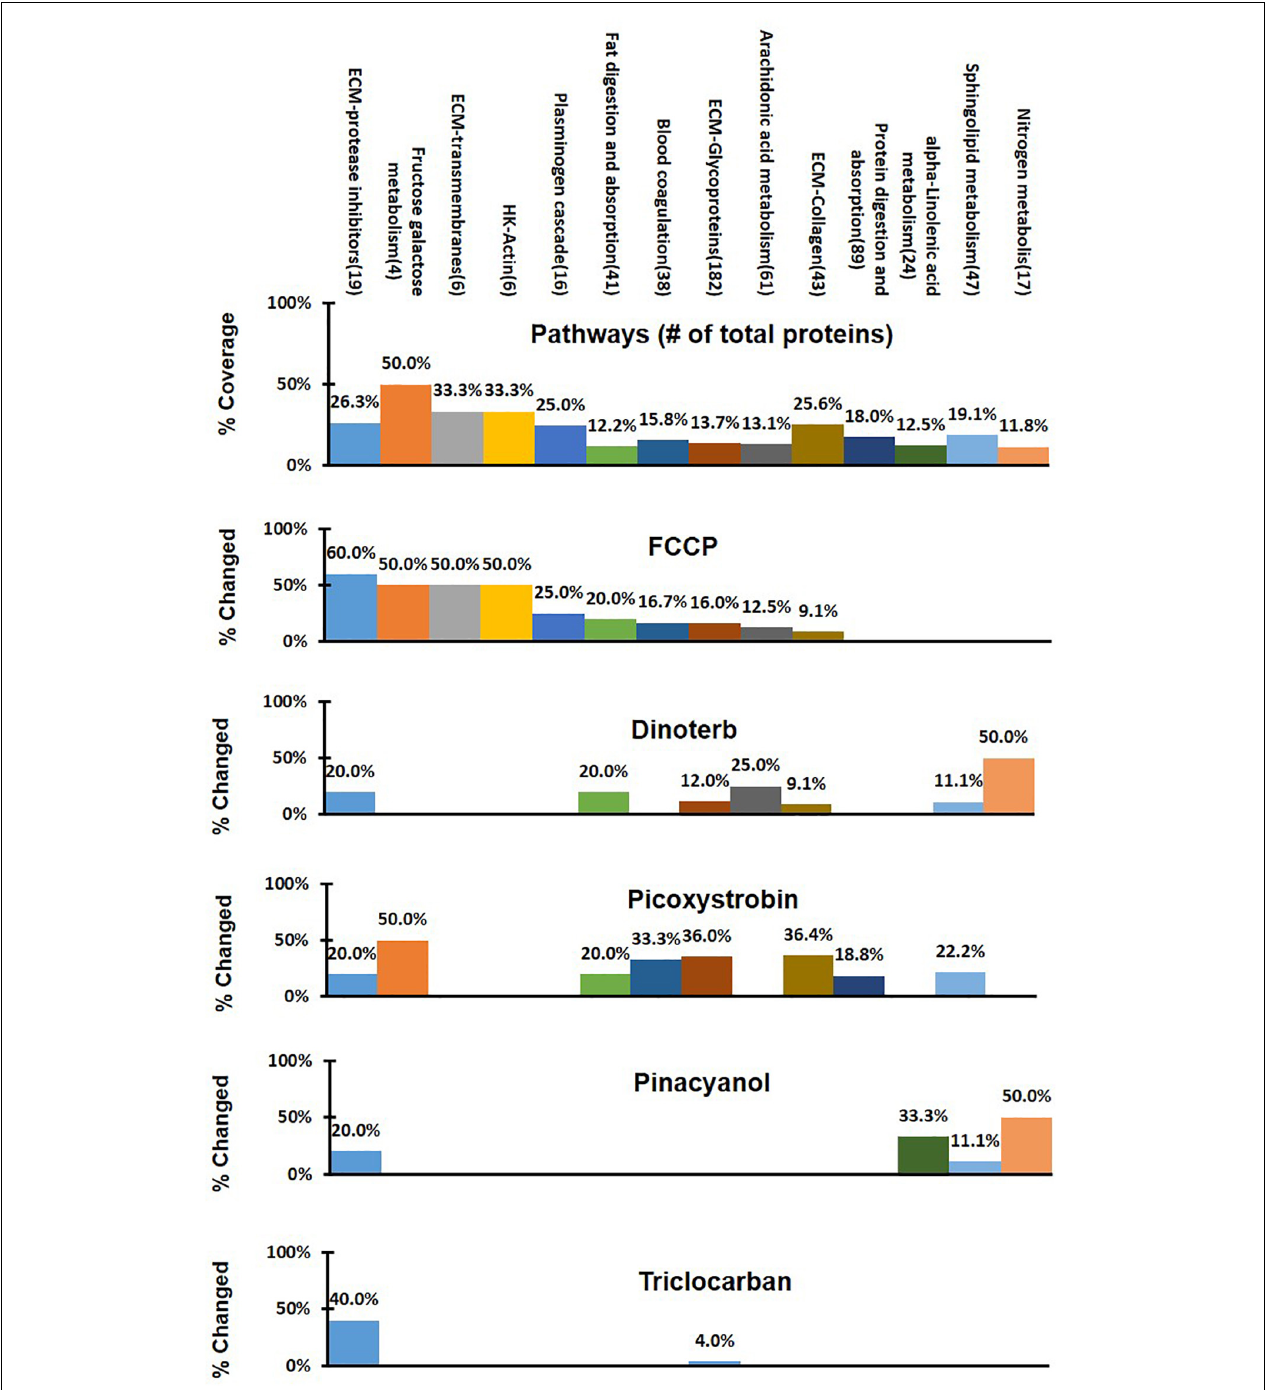
FIGURE 4 | Comparison of different treatment effects on the 14 selected pathways in treatment-specific analysis. Percent of detected proteins in each pathway was shown in the first panel as percent of coverage from all treatment groups. Percent of changed protein in a specific pathway upon different treatments was shown under the percent of coverage, respectively. The colored bars in the five lower panels indicated treatment-specific dysregulated pathway.